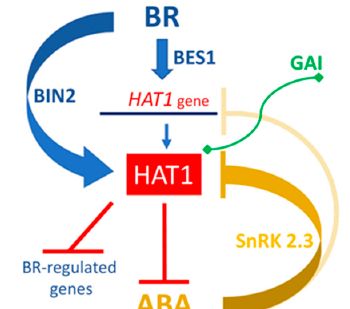
Figure 2. Positive and negative hormonal pathways regulated by HAT1. BR positively regulates the expression of HAT1 through the BES1 transcription factor and stabilizes HAT1 protein through the BIN2 kinase. HAT1 acts together with BES1 as a transcriptional repressor of BR-regulated genes. HAT1, whose expression is negatively regulated by ABA at the transcriptional and post-transcriptional levels, represses the expression of NCED3 and ABA3 resulting in a reduction of ABA synthesis. The SnRK 2.3 kinase, positively acting in the ABA signaling, affects both HAT1 protein stability and DNA binding activity. The GAI interaction with HAT1 is also indicated.